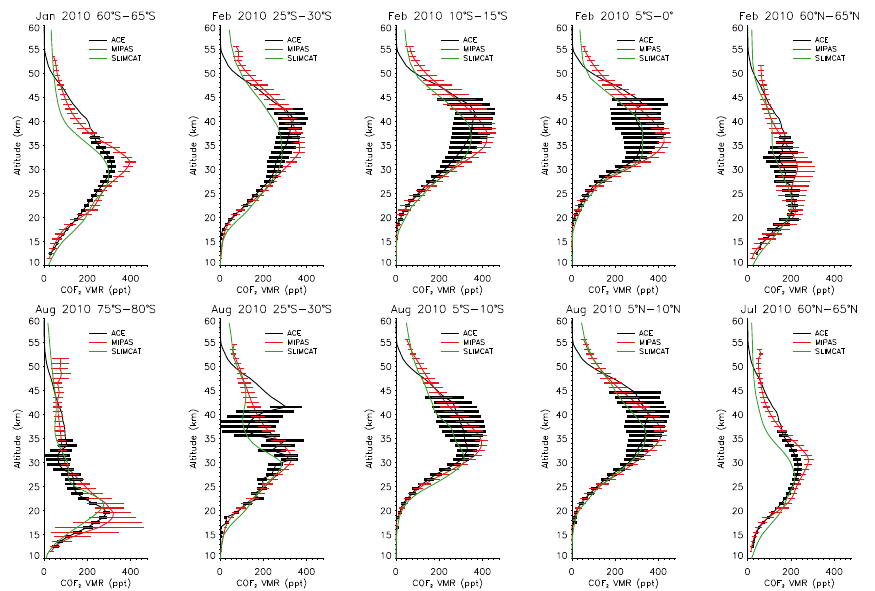
Figure 9. A representative set of MIPAS and ACE individual latitude bins, with errors, taken from Fig. 8. SLIMCAT calculations are also included. A full discussion of the intercomparison is provided in the text.